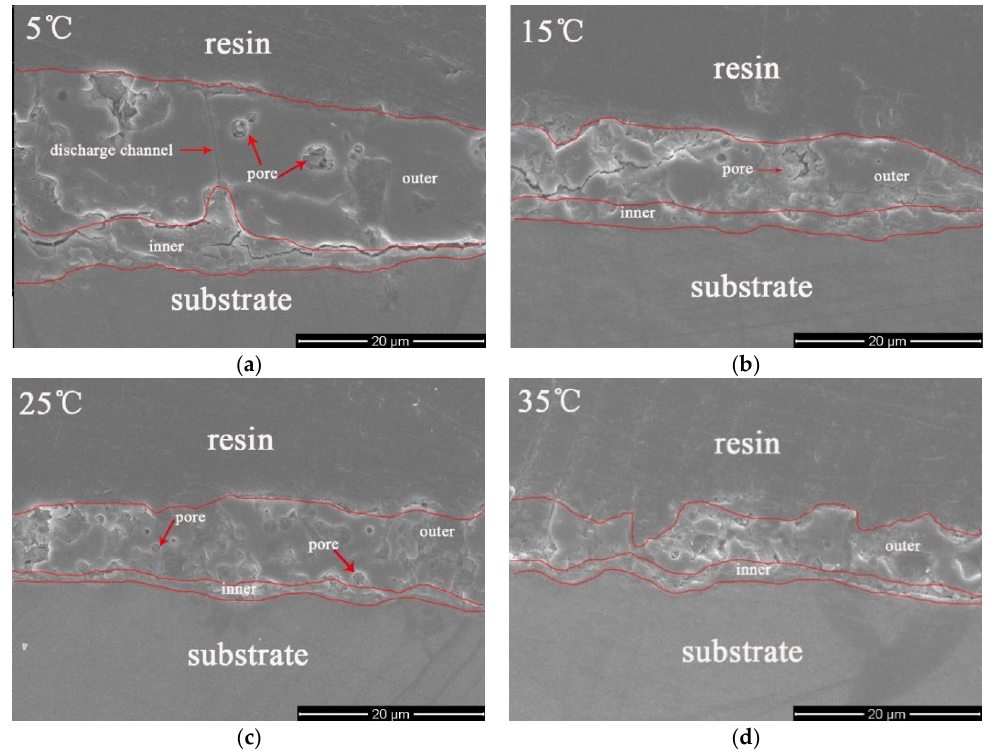
Figure 6. Cross-section SEM images of the PEO coatings prepared at different electrolyte temperatures: ( a ) 5 °C; ( b ) 15 °C; ( c ) 25 °C; ( d ) 35 °C .